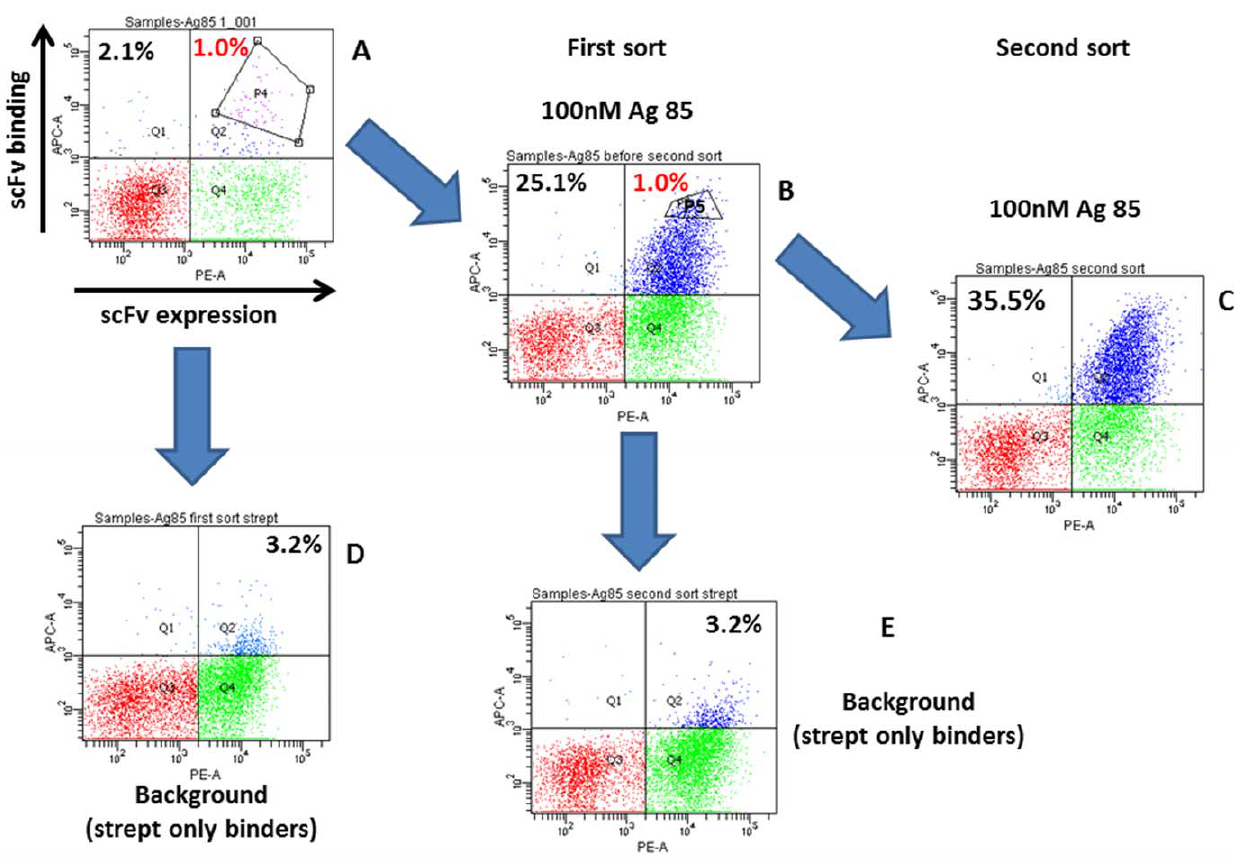
Figure 2. Yeast cell analysis before and after sorting. 2A shows the yeast population after cloning the Ag85 selected phage display output. The upper right quadrant (Q2) representing those yeast that are displaying scFv and binding antigen contains 2.1% of all yeast cells, of which the top 1%, as indicated by the sort gate, were sorted. 2B shows the outcome of the first sort after yeast were collected and grown up. Q2 now contains 25.1% of all yeast cells, of which the top 1% were again sorted as shown. 2C shows the outcome of the second sort: Q2 now contains 35.5% of all yeast cells. 2D and 2E show the background streptavidin binding clones that represent, for both the first and the second sort, 3.2% of the total